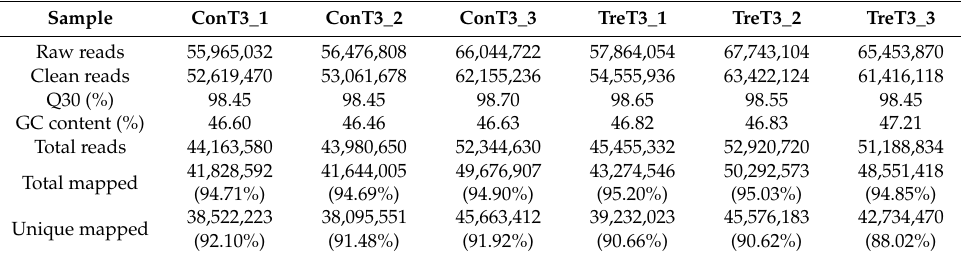
Table 1. Statistical analyses and mapping results of RNA sequencing reads.